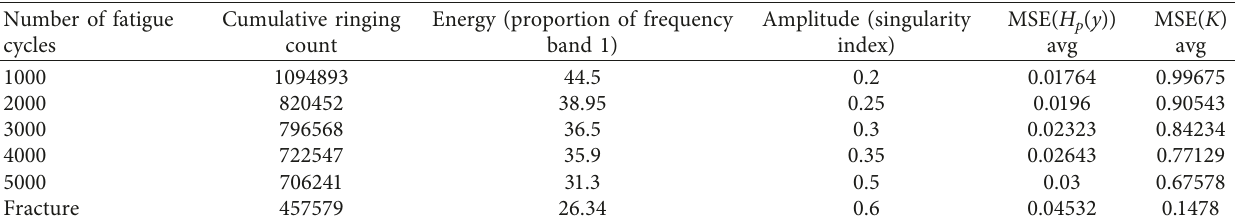
Table 3: Six groups of test data for each damage